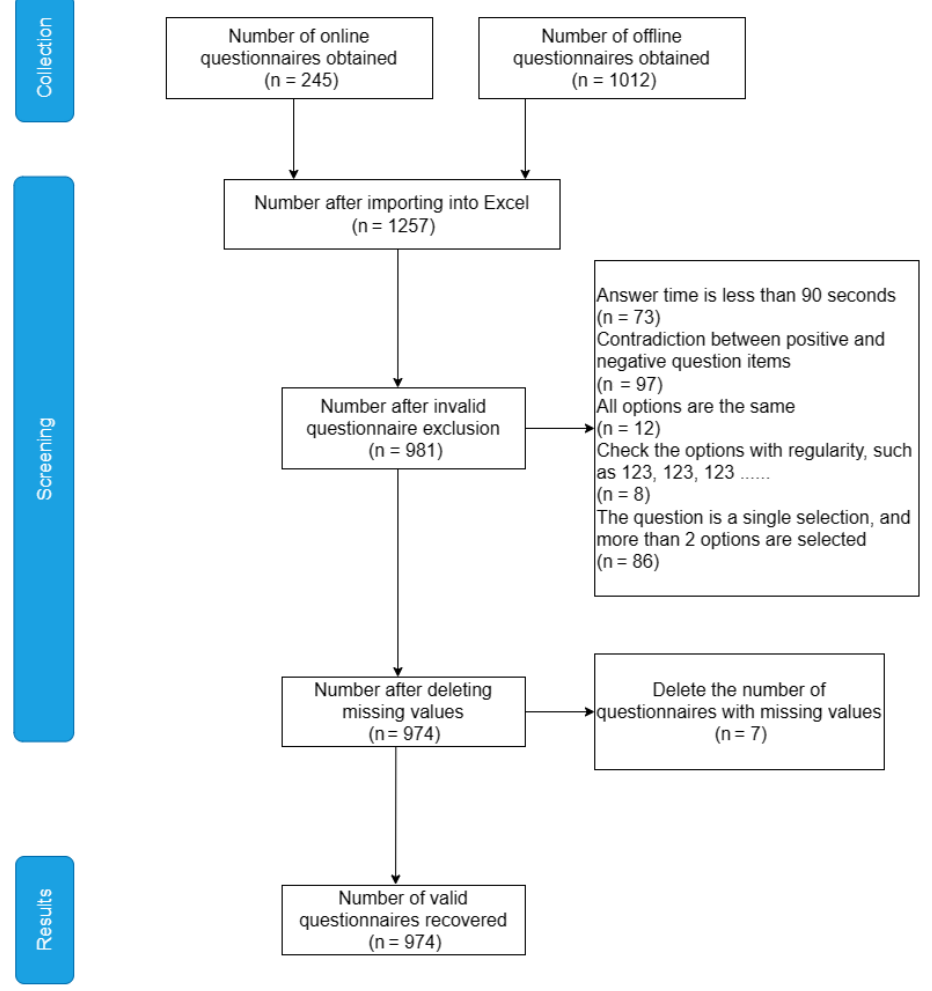
Figure 2. Illustrates the steps for the screening process of the study